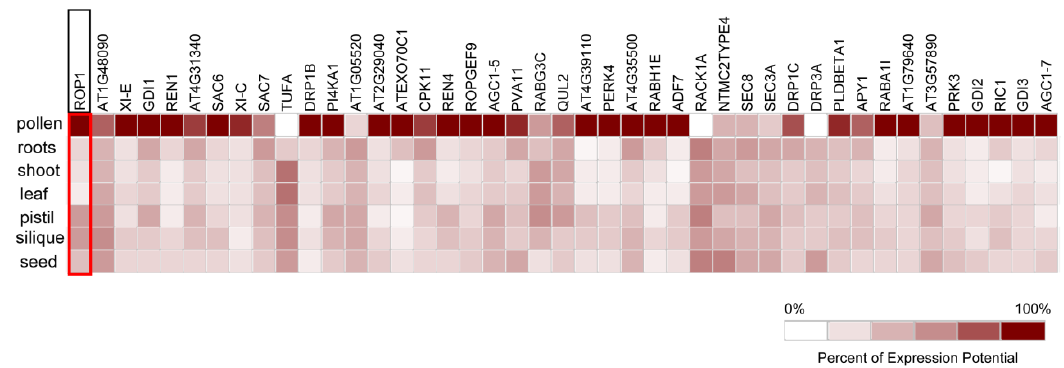
Figure 3. Analysis of expression levels of representative genes found to associate with ROP1 in different tissues of Arabidopsis. The proteins were ranked from left to right according to the detected unique peptide counts ( Table S1 ) in the mass spectrum assay.